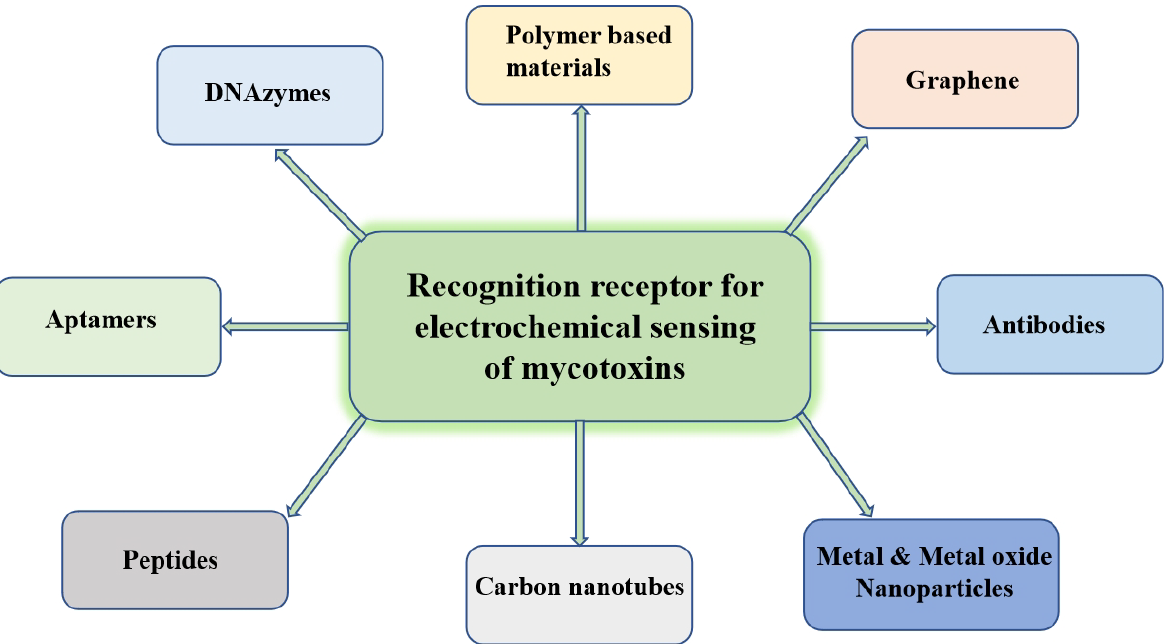
Figure 1. Recognition receptors for electrochemical sensing of mycotoxins. Mechanism of electrochemical biosensing.